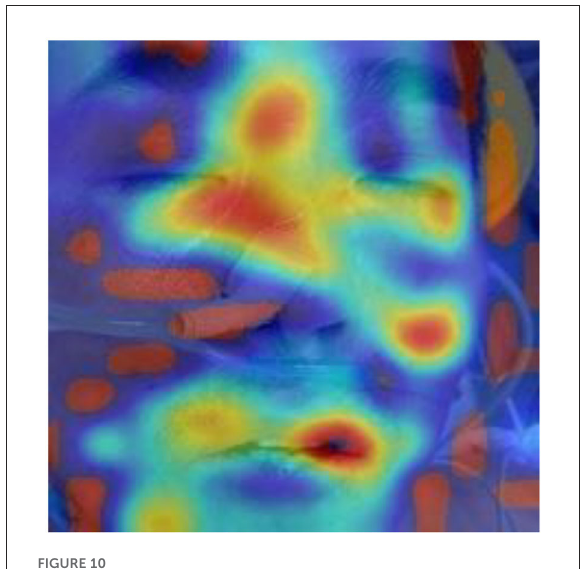
FIGURE10 Fusion image of original image and